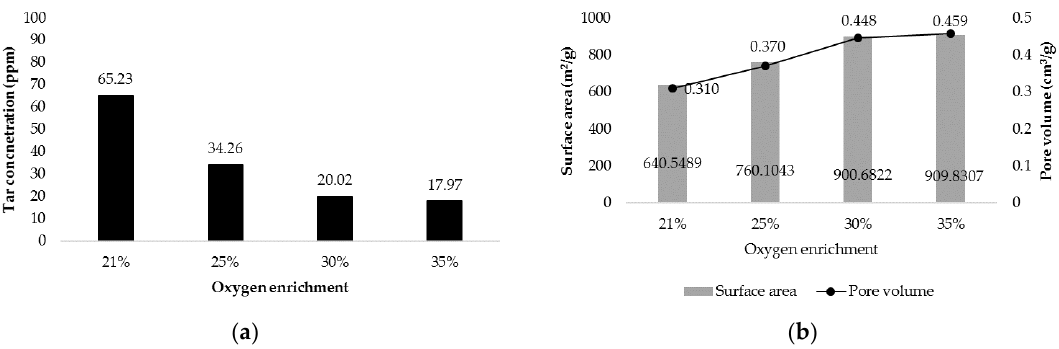
Figure 8. SPA and BET analysis results. ( a ) Tar concentration; ( b ) BET of activated carbon.